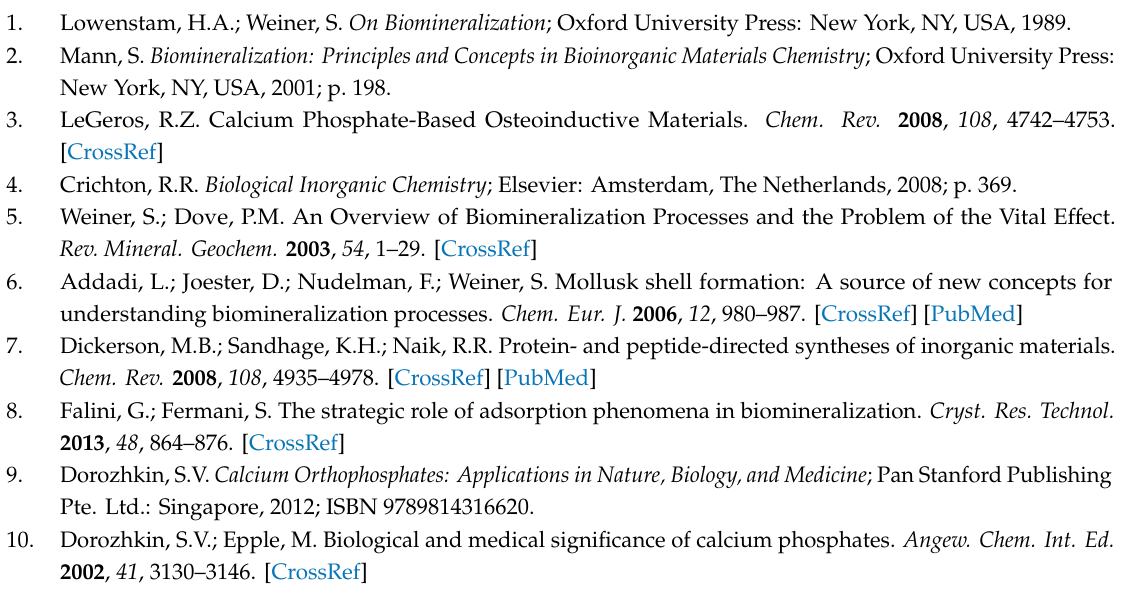
236 cm − 1 ; Table S10: Assignment of reflections in PXRD di ff ractograms of calcium hydrogenphosphate dihydrate (DCPD) seed crystals and precipitates formed in the control system (CS) and in the presence of di ff erent amino acids after 240 min aging time in the system c (CaCl 2 ) = c (Na 2 HPO 4 ) = 4.198 mmol dm − 3 , c (NaCl) = 0.148 mol dm − 3 , m (seed DCPD) = 1 mg, γ (AA) = 10 ppm except γ (Phe) = 5 ppm t = 25 ◦ C, pH initial = 7.4, magnetic stirring. Table S11: Assignment of IR bands in FTIR spectra of calcium hydrogenphosphate dihydrate (DCPD) seed crystals and precipitates formed in the control system (CS) and in the presence of di ff erent amino acids after 240 min aging time in the system c (CaCl 2 ) = c (Na 2 HPO 4 ) = 4.198 mmol dm − 3 , c (NaCl) = 0.148 mol dm − 3 , m (seed DCPD) =